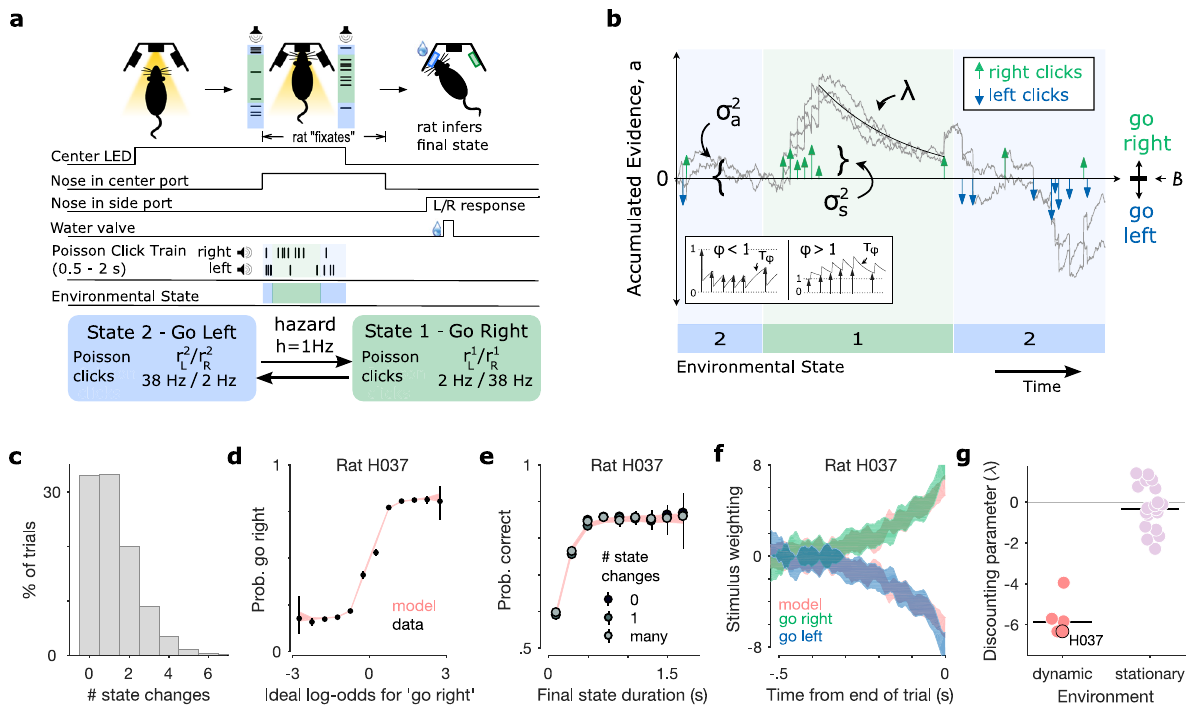
Fig. 1 Rats accumulate and discount evidence in a dynamic accumulation task. a Schematic showing task events and timing. The center port is illuminated by an LED. The rat pokes its nose into the port to initiate playback of randomly timed auditory clicks from speakers on either side. Clicks on each side are generated with different underlying Poisson rate parameters that depend on a hidden environmental state. The stimulus duration is drawn from a uniform distribution between 500 and 2000 ms. During that time the hidden state changes stochastically at a fi xed hazard rate, h = 1 Hz . At the end of the stimulus presentation, the center LED turns off and reward is baited in the side port corresponding to the fi nal state. b Schematic of the evolution of the accumulation model on an example trial. Three example accumulation traces are shown for different instantiations of the noise applied at each time point ( σ a ) and the noise applied to each click ( σ s ). Neighboring clicks can either depress or facilitate each other according to the adaptation parameters ( ϕ and τ ϕ ). The evidence discounting rate ( λ ) determines how quickly the decision variable a decays back to zero. At the end of the trial, a choice is made by comparing the decision variable to the decision boundary parameter B . c Frequency of state changes per trial across all rats' datasets. d Example psychometric plot showing the probability that the rat chooses “ go right ” as a function of the ideal observer log-odds supporting a “ go right ” choice. Rat data (black points) is overlaid on predictions of the accumulation model with parameters fi t to this rat (red traces). Errorbars for rat data represent 95% binomial con fi dence intervals around the mean ( n = 92,468 trials from 252 sessions). e Example fi nal state chronometric plot for the same dataset as in ( d ). Accuracy (mean with 95% binomial con fi dence intervals) is plotted as a function of the duration of a trial ’ s fi nal state and the number of state changes in a given trial. f Psychophysical reverse correlation kernel for the same dataset as in ( d ) and ( e ). Green and blue patches indicate strength (mean ± s.d.) of evidence favoring rightward choice as a function of time until the trial ends for rightward and leftward choices, respectively. The red patches are corresponding predictions from the accumulation model. g Discounting parameters for each rat in this study (red points) compared to each rat in a previously published stationary environment (lilac points; Brunton et al. 8 ). Group medians are plotted as black horizontal lines. Source data are provided as a Source Data fi